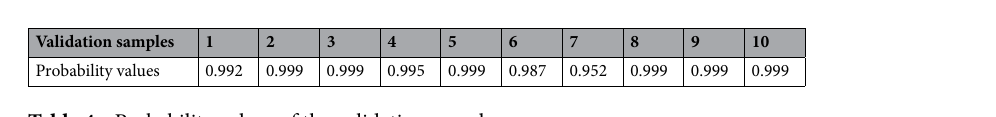
Table 4. Probability values of the validation